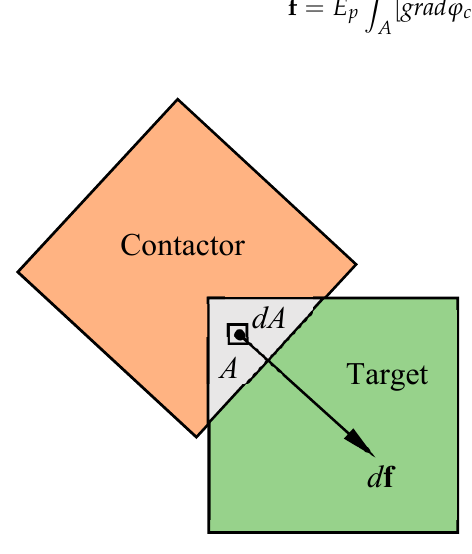
Figure 2. Contact forces in the 2D FDEM. Further details on the contact forces can be referred to Munjiza